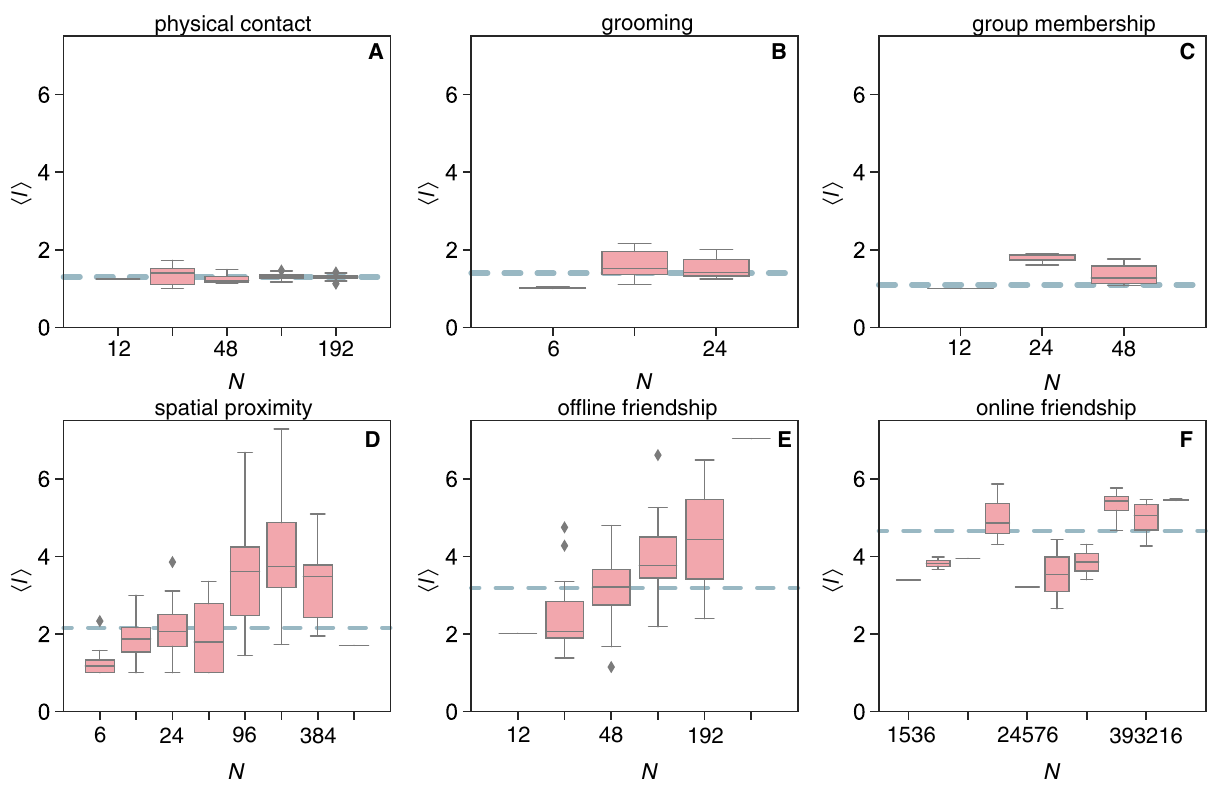
Figure 3. Network path structures. The average shortest path-length (cid:31) l (cid:30) vs. network size in the networks of ( A ) physical contact (median values for the empirical M emp = 1.10 and randomised M rand = 1.05 versions of the original network); ( B ) grooming ( M emp = 1.39 and M rand = 1.29 ); ( C ) group membership ( M emp = 1.30 and M rand = 1.09 ); ( D ) spatial proximity ( M emp = 2.16 and M rand = 2.00 ); ( E ) offline friendship ( M emp = 3.19 and M rand = 3.36 ); ( F ) online friendship ( M emp = 4.66 and M rand = 4.97 ). Dashed horizontal lines are the median values of the empirical networks. Log-binned (x-axes) Tukey box plots with diamonds representing